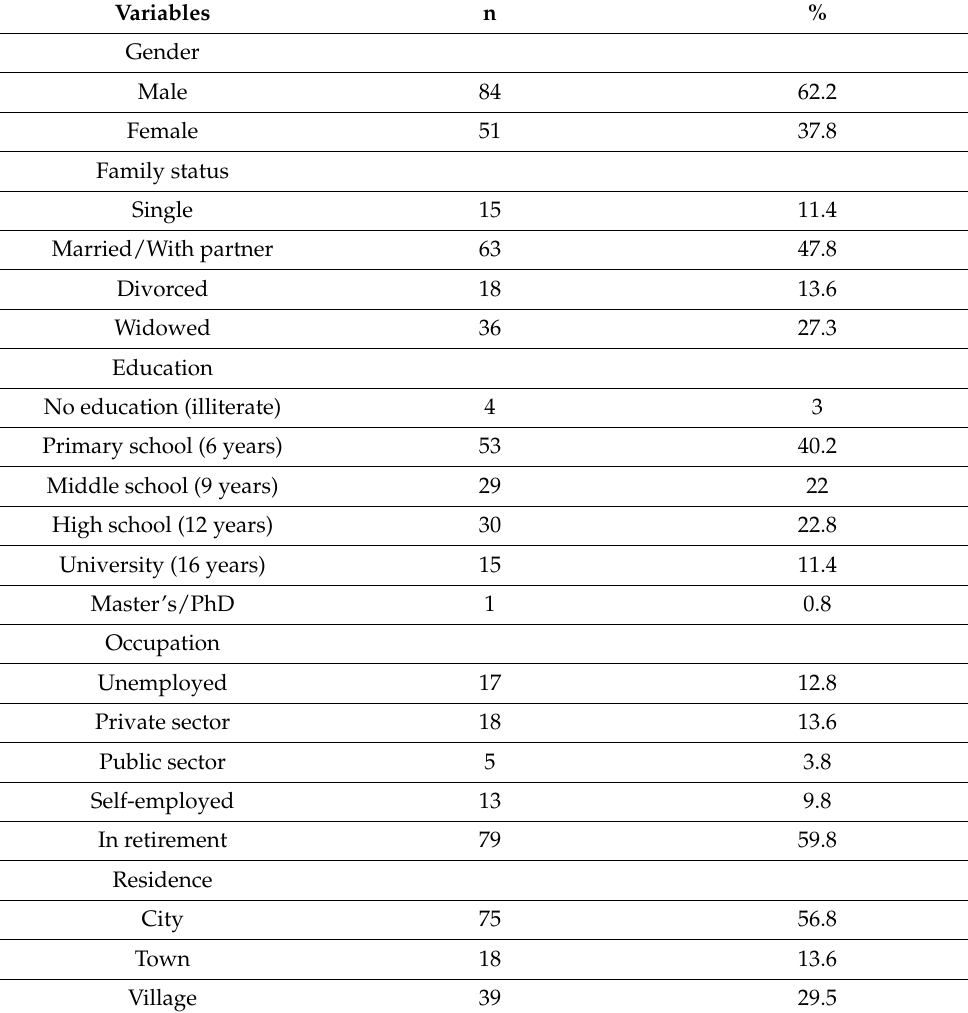
Table 1. Demographic characteristics of patient